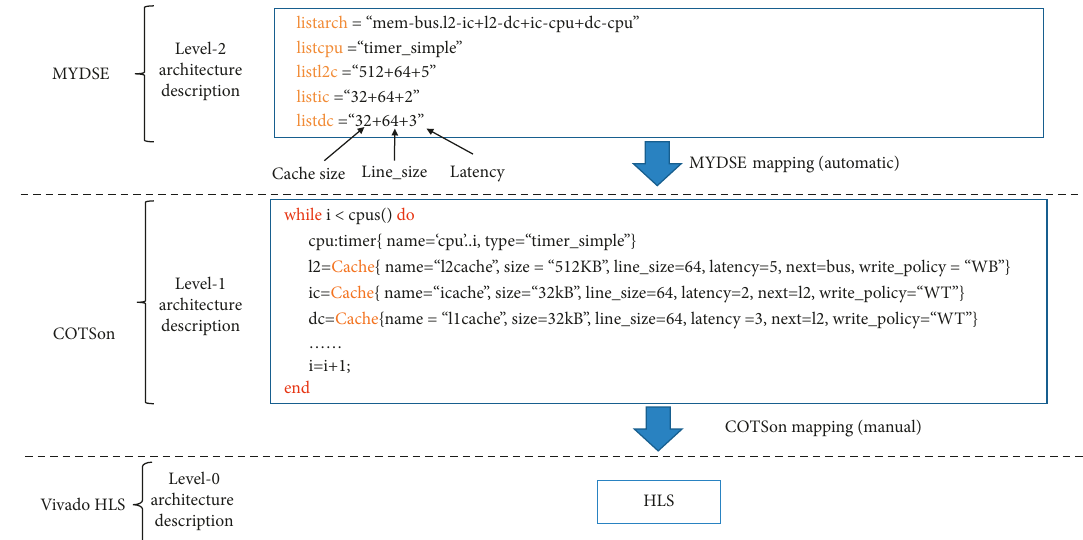
Figure 3: The relation between the higher level MYDSE description, the COTSon configuration file, and the final HLS translation: At the higher level, we specify the parameters in a compact way (level 2 architecture description), and we can indicate several instances of such parameters so that MYDSE can generate the design space points to be explored. In the COTSon configuration (level 1), the MYDSE points will be automatically mapped to the parameter of the corresponding architectural element (bottom part of the figure: the “next” field specifies the position in the architecture tree, WB means write-back, and WT is the write-through policy). Finally, the architecture de- scription is mapped manually from COTSon description to HLS (level